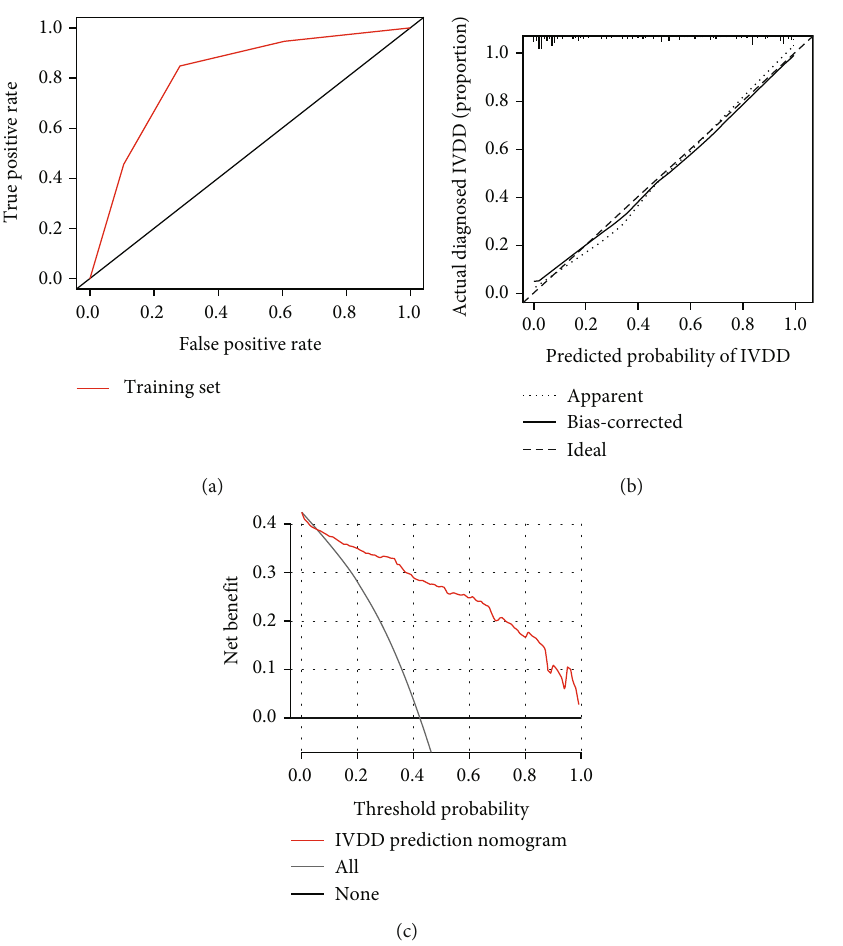
Figure 4: The ROC curve, calibration curve. and DCA curve of the training group. (a) The ROC curve of the nomogram model. (b) The calibration curve of the training group. (c) The decision curve of the training